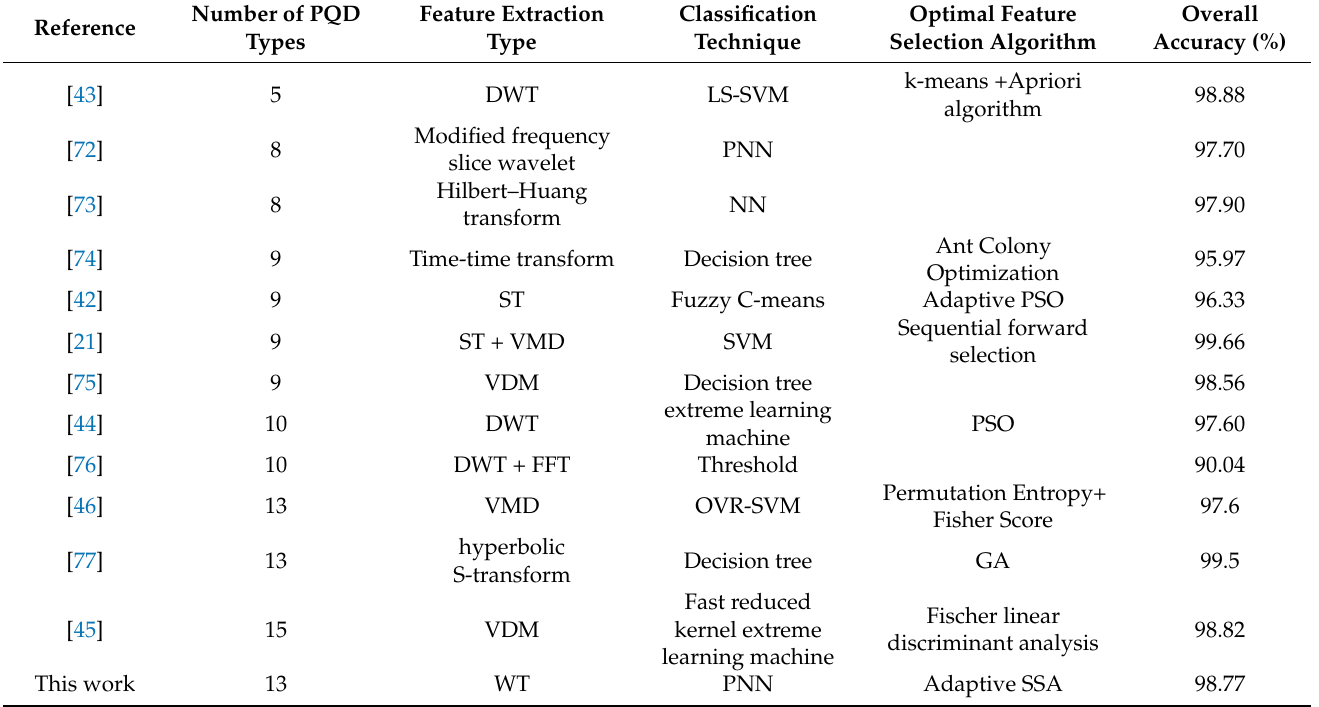
Table 10. Comparison of classification accuracy to the existing